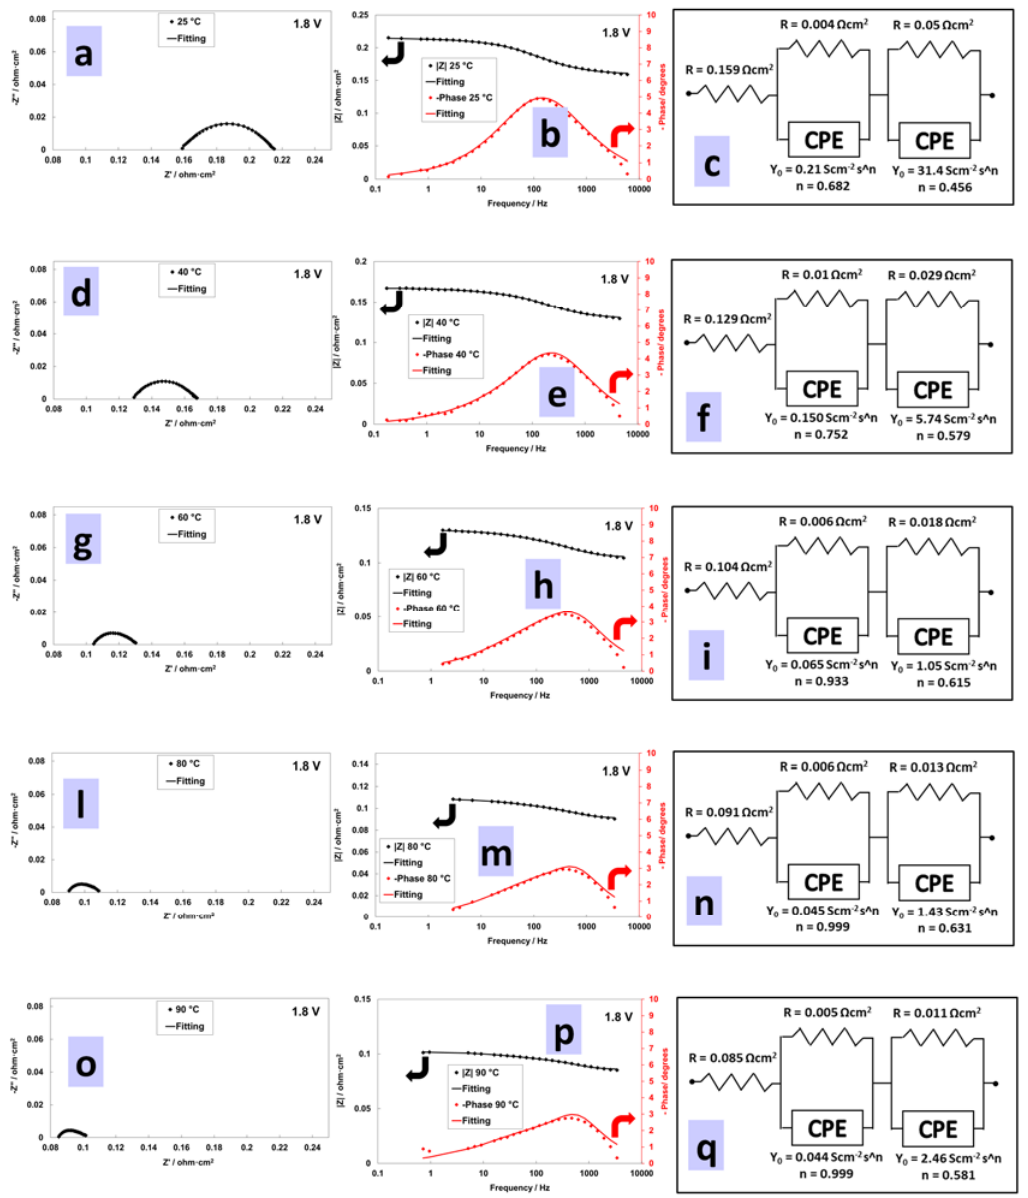
Figure 9. EIS at 1.8 V for low catalyst loading at 25 °C ( a – c ), 40 °C ( d – f ), 60 °C ( g – i ), 80 °C ( l – n ), 90 °C ( o – q ).